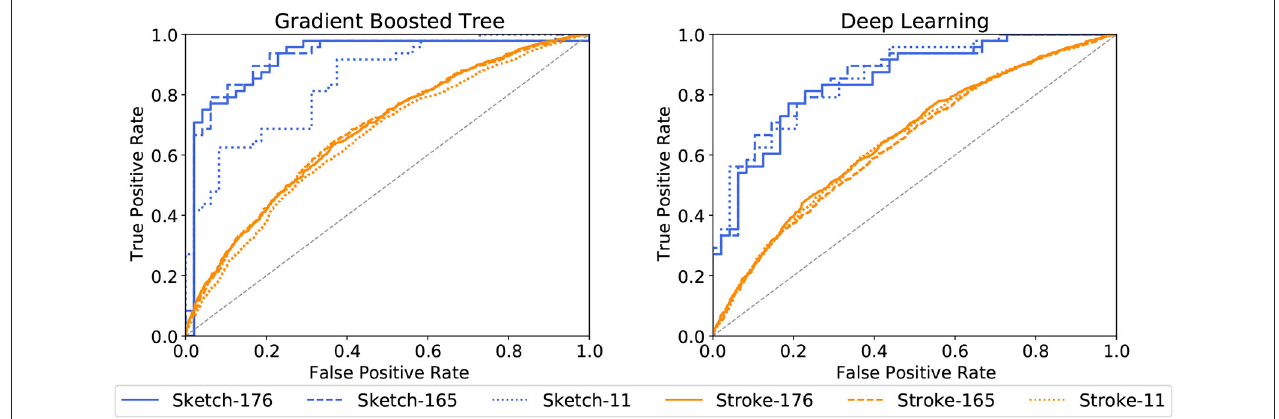
FIGURE 9 | ROC curves for cognitive test performance classification per ML method and feature subset